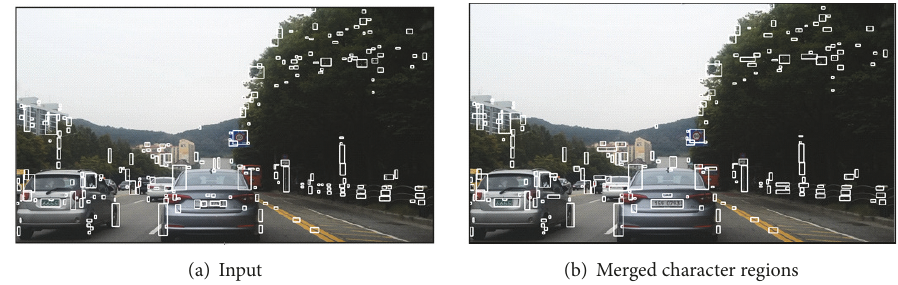
Figure 5: Candidate plate regions from merging character areas.